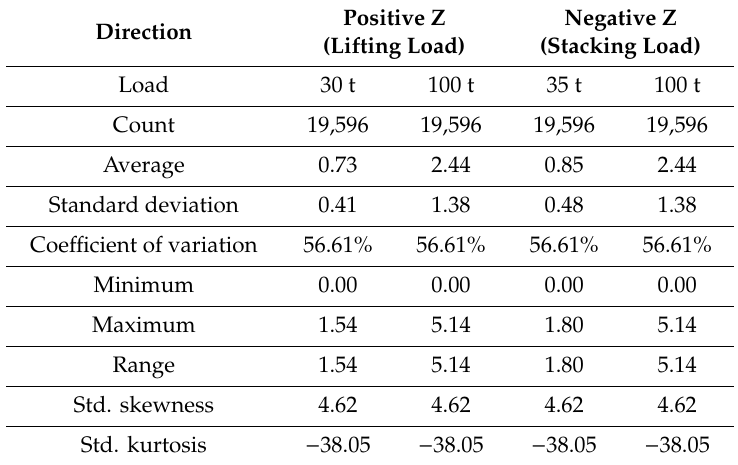
Table 6. Summary statistics of total deformations under various loads in the + Z or − Z direction.